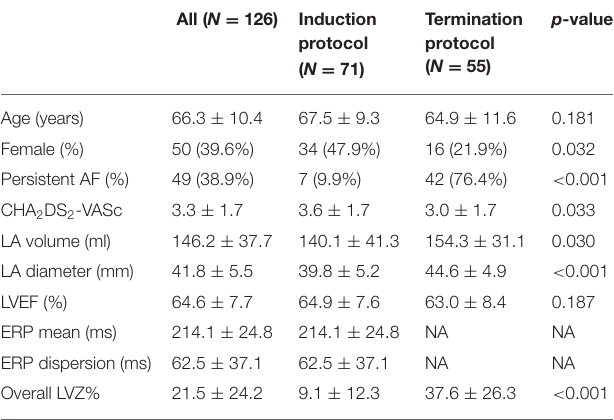
TABLE 1 | Baseline characteristics of patients in induction and termination